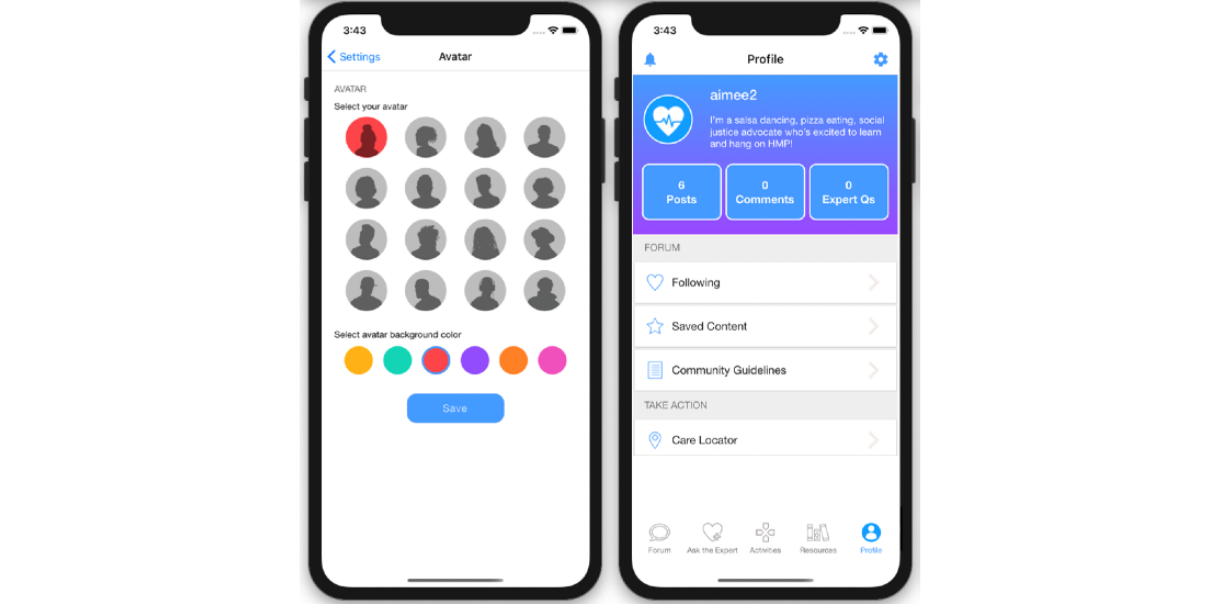
Figure 7. Example screenshots from avatar and personalized profile for HealthMpowerment (HMP) 2.0 intervention arms.